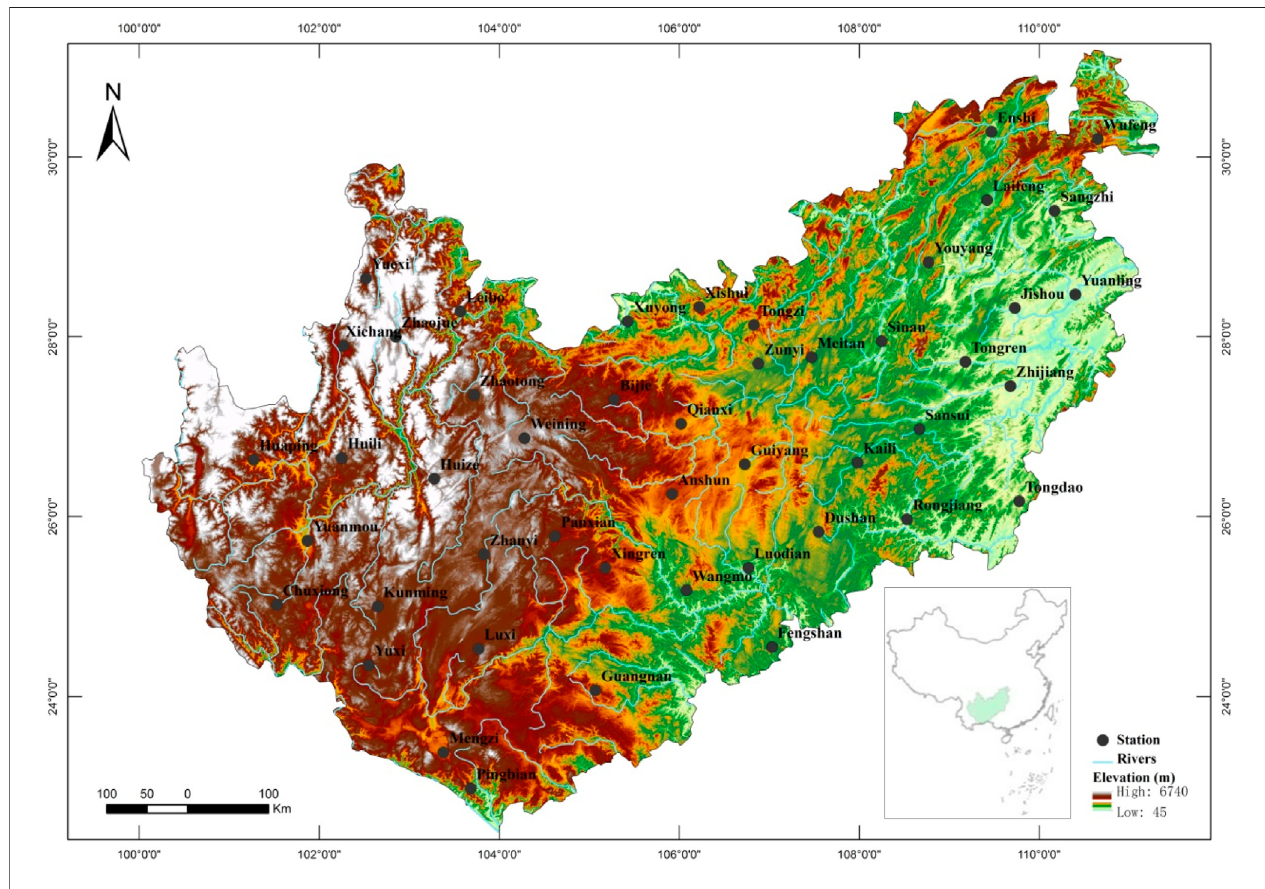
FIGURE 1 | Location of the YGP and meteorological